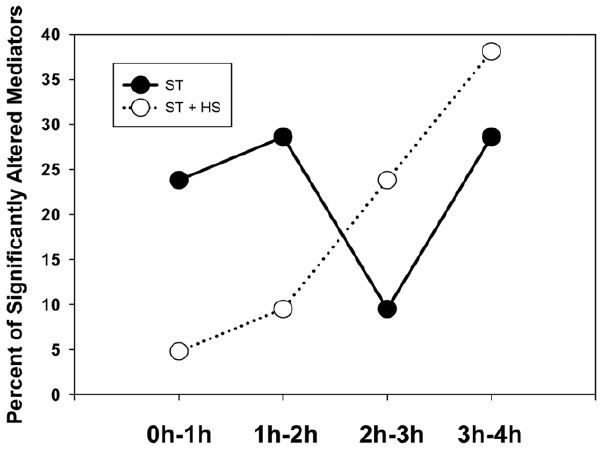
Figure 2. Percent of inflammatory analytes modulated as a function of time and procedure. Mice were subjected to ST 6 HS followed by measurement of cytokines, chemokines, and NO 2 2 /NO 3 2 as described in the Materials and Methods . In each adjacent 1–h time period (0–1 h, 1–2 h, 2–3 h, and 3–4 h), the statistically significantly altered inflammatory analytes (p , 0.05 by Student’s t-test) were selected out of the total 21 mediators by comparing the level of a given mediator with its baseline value (no treatment [time